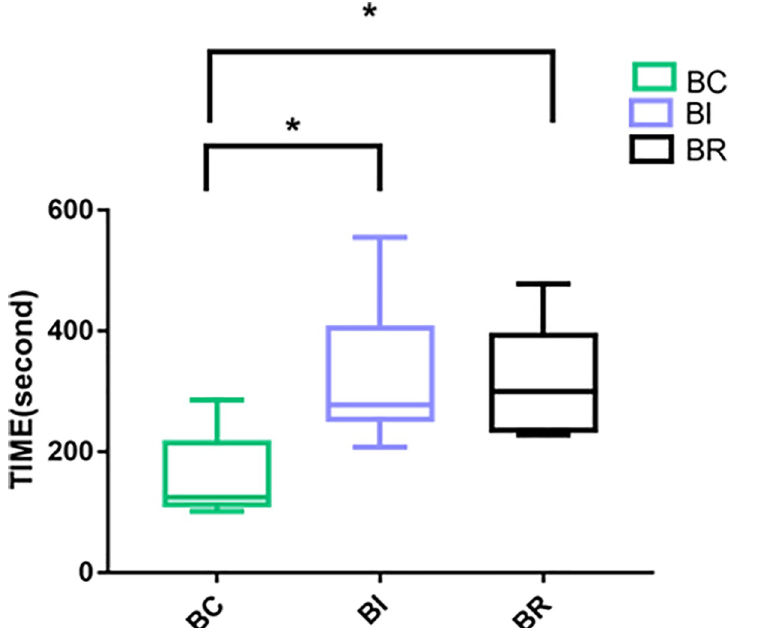
Fig 7. The average adjustment time of BC, BI and BR modes. � p < 0.05.